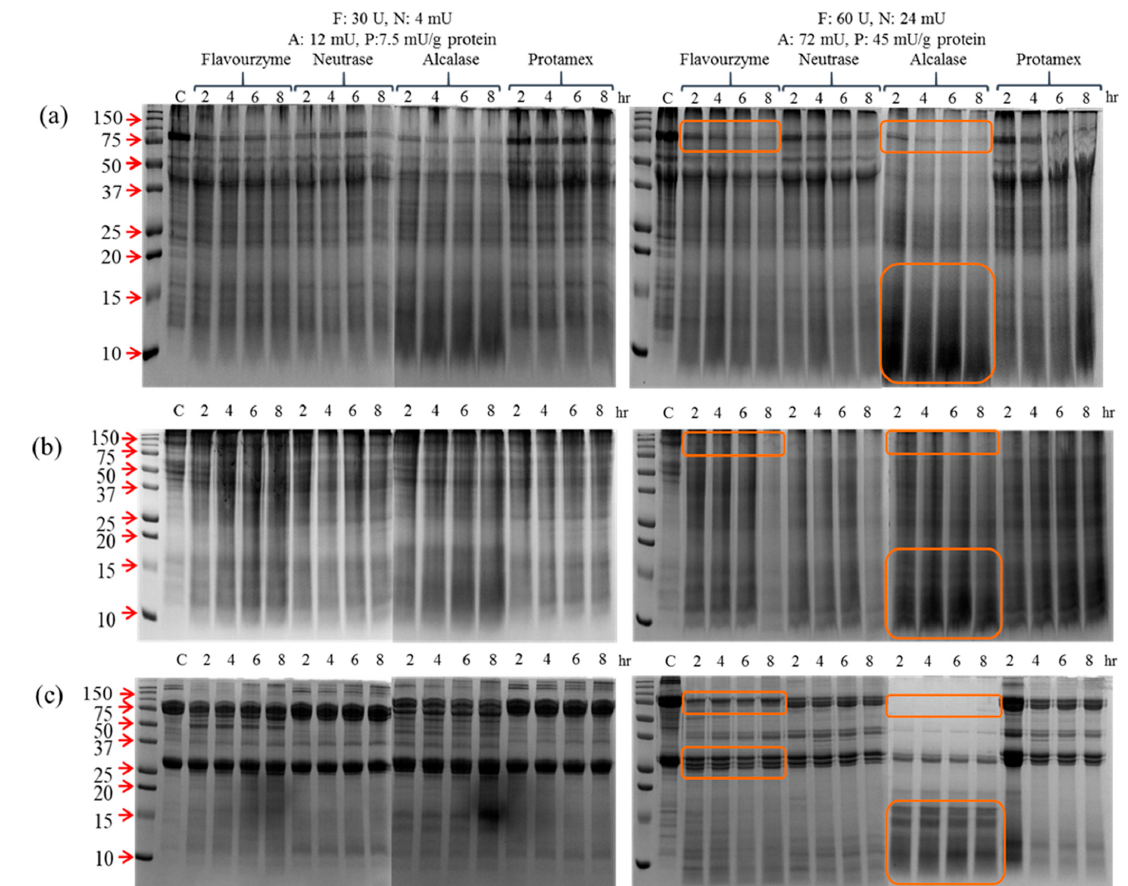
Figure 1. Hydrolysis pattern of ( a ) mealworm, ( b ) cricket, and ( c ) silkworm pupae protein extracts by four commercial proteases. Two different doses of enzymes were applied. Left: Flavourzyme: 30 U, Neutrase: 4 mU, Alcalase: 12 mU, and Protamex: 7.5 mU/g protein. Right: Flavourzyme: 60 U, Neutrase: 24 mU, Alcalase: 72 mU, and Protamex: 45 mU/g protein. The numbers above the lanes signify the